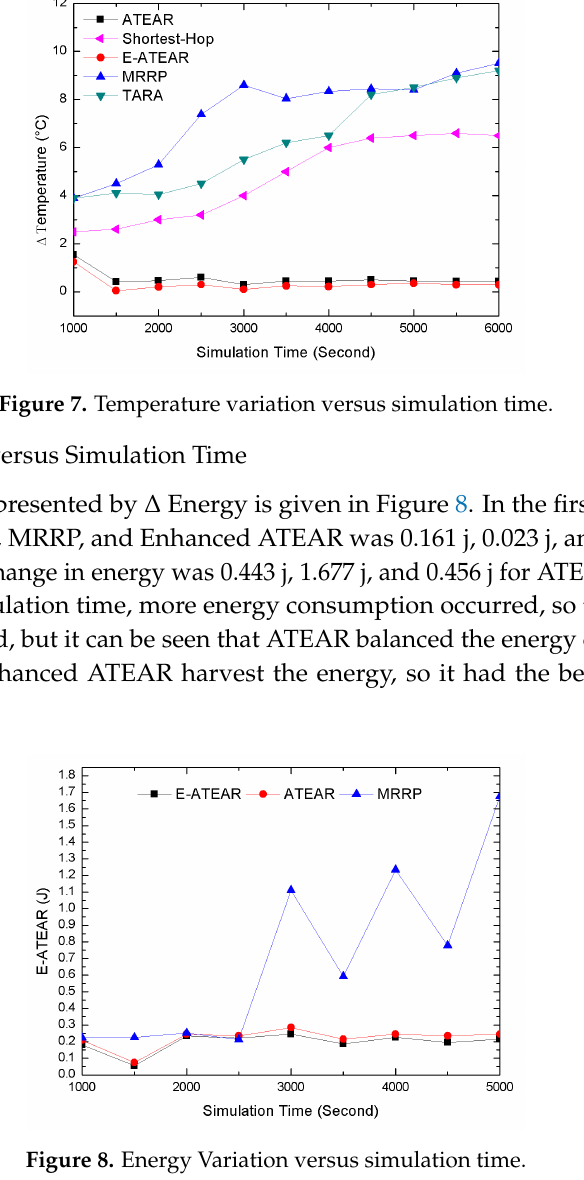
Figure 8. Energy Variation versus simulation